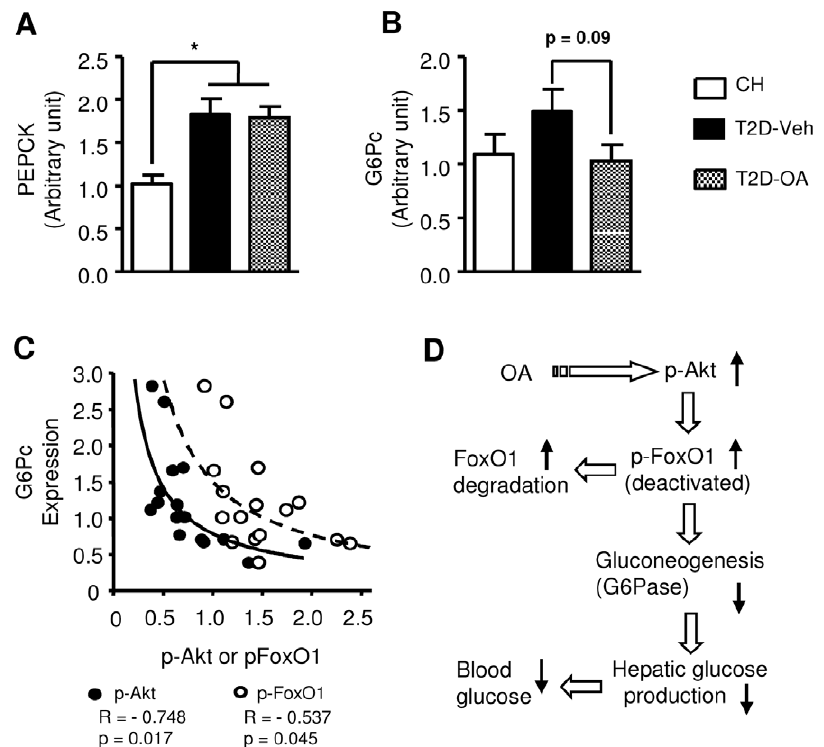
Figure 9. Changes in PEPCK and G6Pase expression in the liver 4 weeks after the removal of OA. Four weeks after the cessation of OA treatment, mice were sacrificed following a 5–7 hour fast. Liver samples were freeze-clamped and stored for subsequent analysis of PEPCK and G6Pase RNA expression. The expression levels of PEPCK and G6Pase mRNA relative to 18S ( A and B ). Correlation of p-Akt/GAPDH and FoxO1/GAPDH with G6Pase mRNA expression in T2D-Veh and T2D-OA groups by a best-fit regression analysis ( C ). * p , 0.05 vs. CH, n=6–8 per group. Proposed mechanism for the sustained reduction in hyperglycemia following the treatment of OA ( D ).